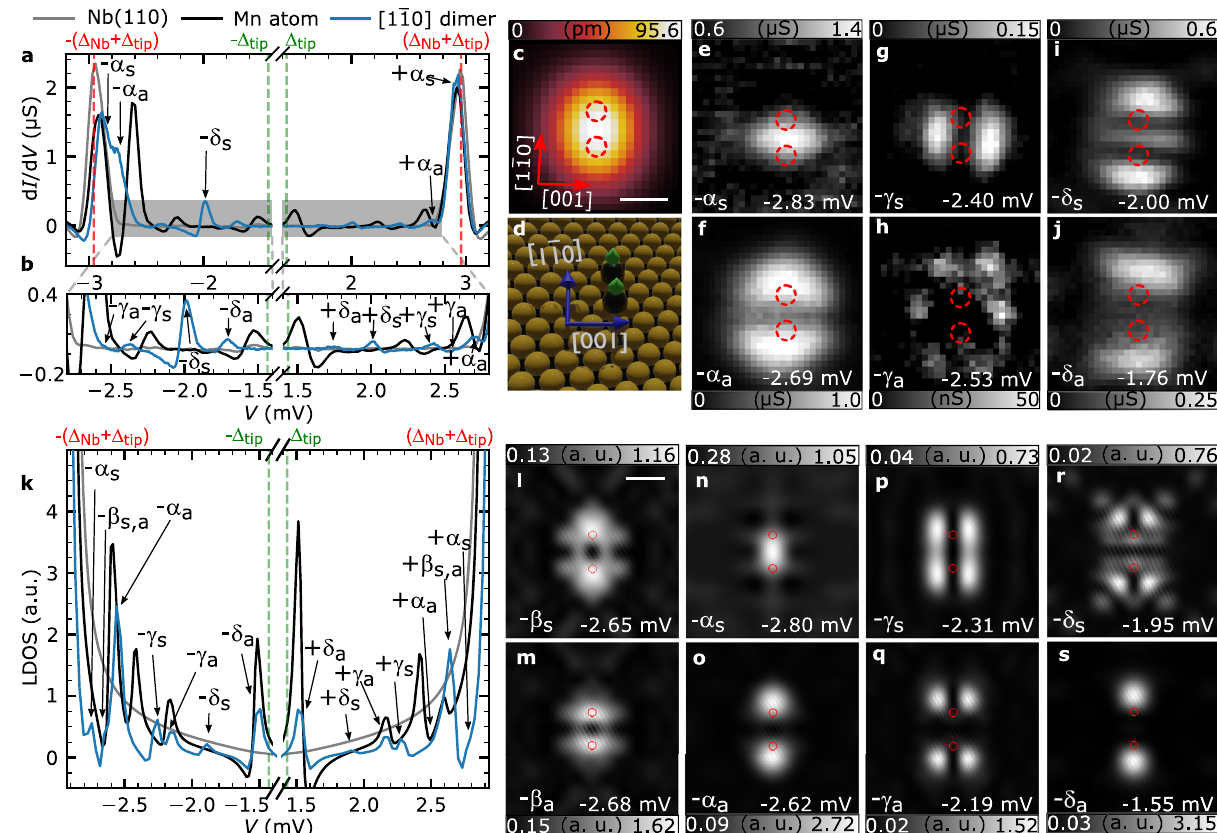
ffiffiffi p ffiffiffi p -- a (cid:3) ½ 1 a (cid:3) ½ 1 (cid:1) 10 (cid:2) dimer (blue) 2 Fig. 2 Hybridized Shiba states in a FM-coupled 2 10 (cid:2) Mn dimer. a d I /d V spectrum taken between the two atoms of a with reference spectra for the substrate (gray) and a single Mn adatom (black). b Magni fi cation of the spectra shown in panel a . Shiba states are labeled ffiffiffi p a (cid:3) ½ 1 (cid:1) 10 (cid:2) Mn dimer. The white scale bar has a length of and marked by arrows. Vertical lines mark sample and tip gaps. c Small-scale STM image of a 2 500 pm ( V bias = 6 mV and I = 1 nA). The directions and the scale bar also apply to panels e – j . d 3D rendered illustration of the positions of the two Mn adatoms (black spheres) in the investigated dimer with respect to the Nb substrate atoms (yellow spheres), including the spin structure indicated by green arrows. e – j d I /d V maps measured on the dimer in the same area shown in panel c for the given bias voltages where a peak/shoulder is visible in the spectrum in a and b . The d I /d V maps taken at the Shiba peaks on the positive bias side are shown in Supplementary Fig. 6. LDOS calculated between the ffiffiffi p a (cid:3) ½ 1 (cid:1) 10 (cid:2) dimer (blue), on a single adatom (black) and on the bare superconductor (gray) convoluted with the DOS of the two atoms of the FM-aligned 2 superconducting tip. l – s Calculated two-dimensional maps of the LDOS at the indicated bias voltages. The white scale bar has a length of 500 pm; crystallographic directions as in panel c . Red circles in c , e – j and l – s denote the locations of the Mn adatoms in the dimer.